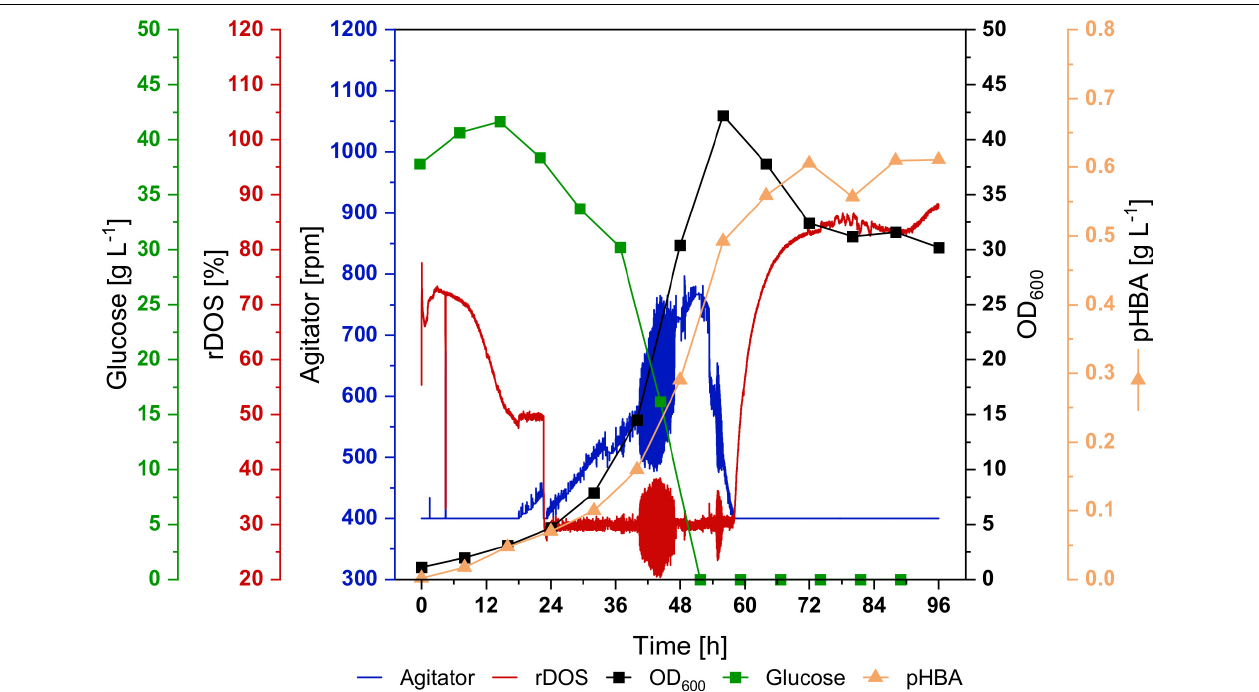
FIGURE 8 | Batch fermentation of C. glutamicum UBI413 in 2-L scale. The cultivation was performed in CGXII medium with 40 g L − 1 glucose, supplemented with 0.5 g L − 1 of L -methionine, antibiotics, 1 mM of IPTG and 0.25 µ g mL − 1 of ATc for induction of gene expression at 30 ◦ C, pH 7.0 and an aeration rate of 2 NL min − 1 . The rDOS was maintained at 30% by control of agitator frequency. Glucose concentration (green) and OD 600 (black) are shown in squares, rDOS (red) and agitator frequency (blue) are indicated by lines, production of pHBA is shown in triangles. An upper estimate of CoQ10 production is given in the